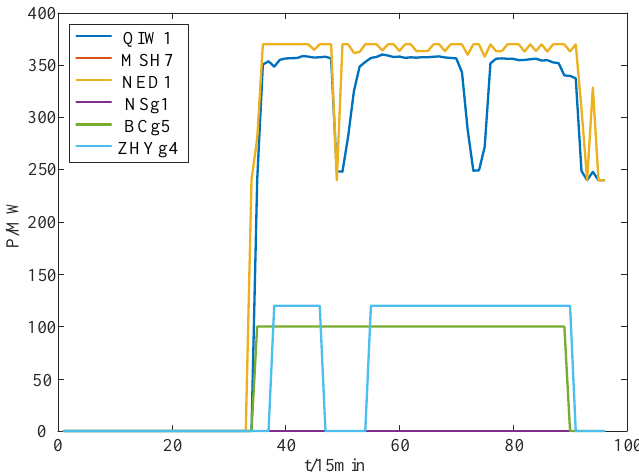
Figure 19. Active power output schedule of gas-fired units.